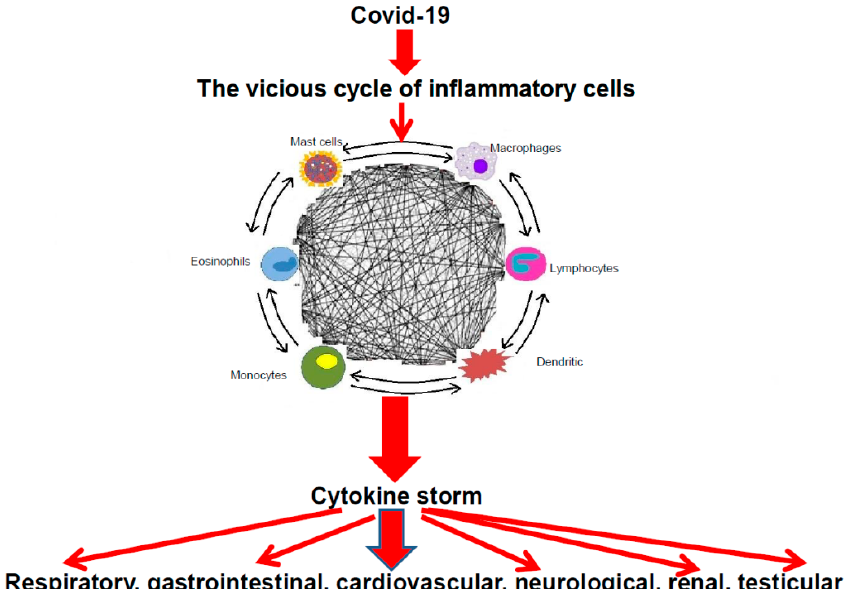
Figure 1. The cascade of COVID-19 and the vicious cycle of inflammatory cells leading to cytokine storm with their clinical consequences. storm with their clinical